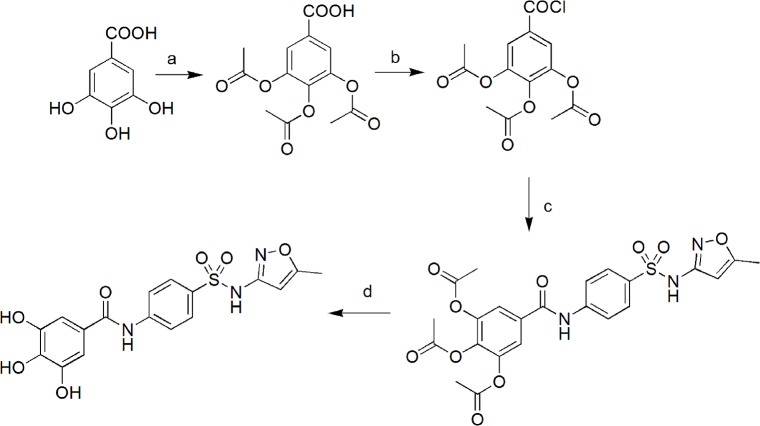
Reagents and conditions: (a) Acetyl oxide, oil bath, 120°C (b) SOCl2, oil bath, 80°C (c) Sulfamethoxazole, THF, Pyridine, ice bath (d) HCl, THF, 60°C.